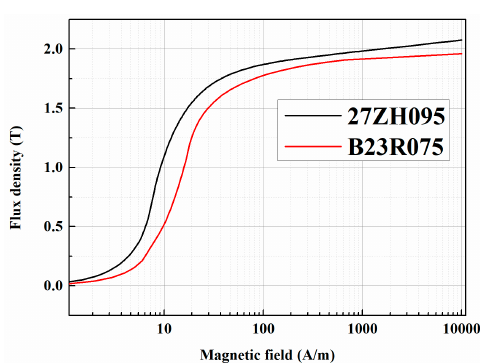
Figure 3. B-H curve of UHV transformer as 27ZH095 and RSM as